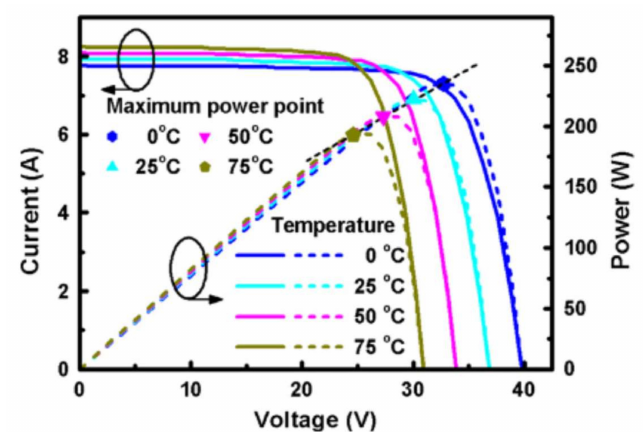
Figure 6. I-V and P-V characteristic curves of the photovoltaic panel.